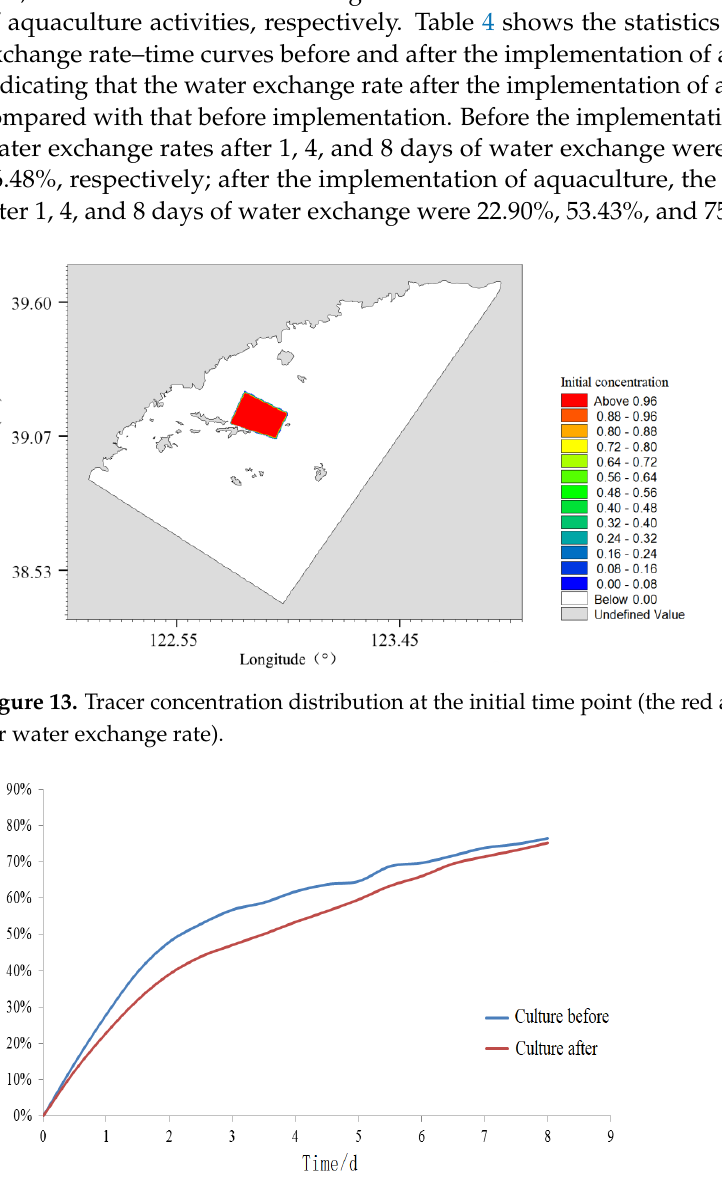
Figure 14. Water exchange rate–time curves before and after the implementation of aquaculture. Table 4. Statistics for the water exchange rate–time curves before and after the implementation of aquaculture.